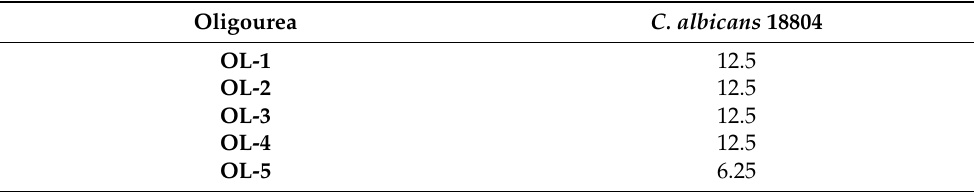
Table 3. Antifungal activity of the foldamers (MIC in µ g/mL). One colony of C. albicans was